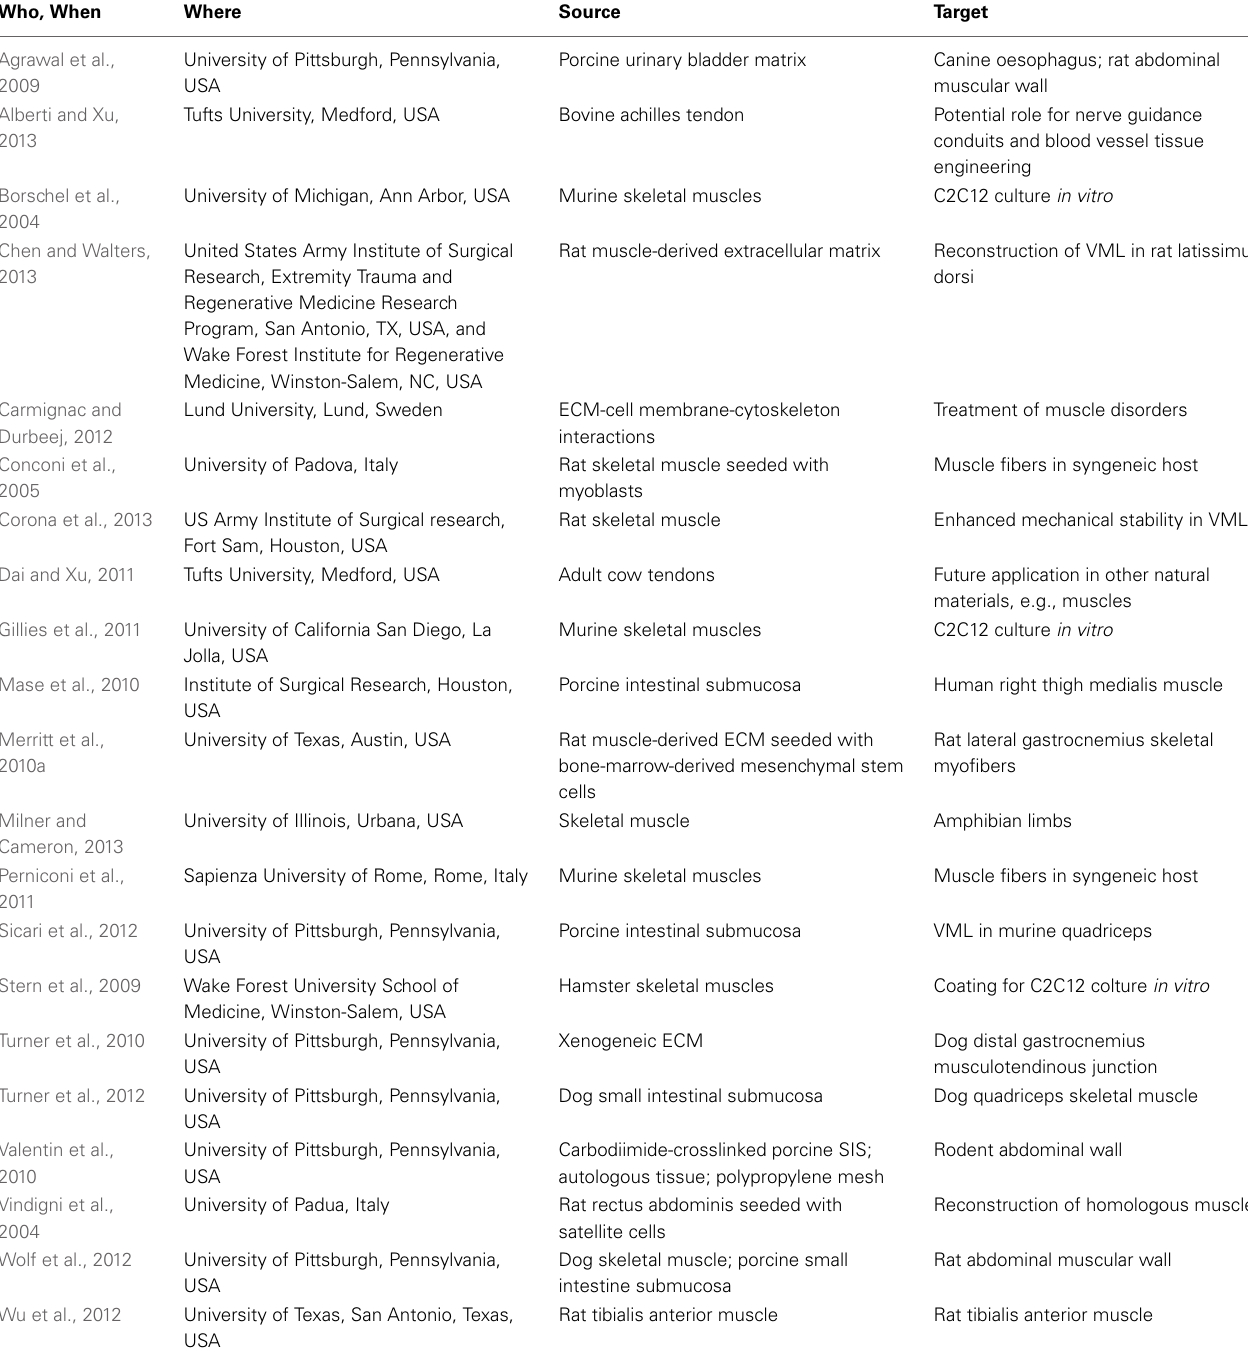
Table 1 | Overview of the literature on ECM-based bioscaffolds. Who, When